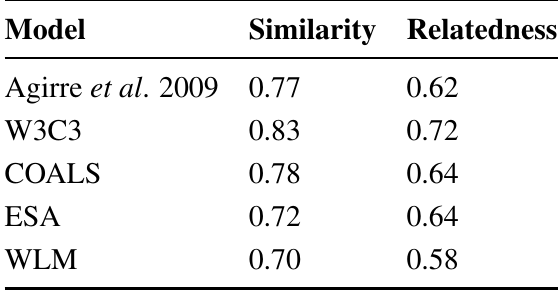
Table 4. Correlations with WordSimilarity-353 similarity and relatedness